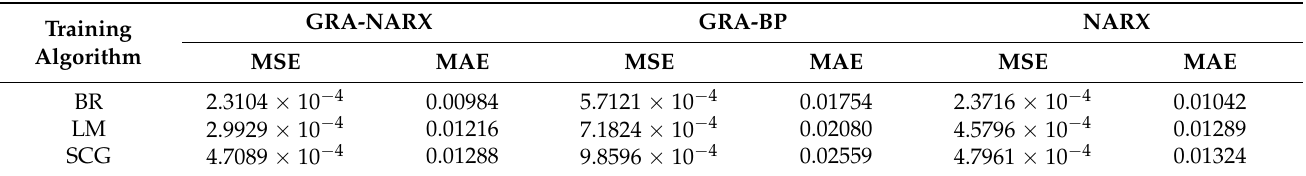
Table 4. The MSE and MAE values for the three models with different training algorithms.